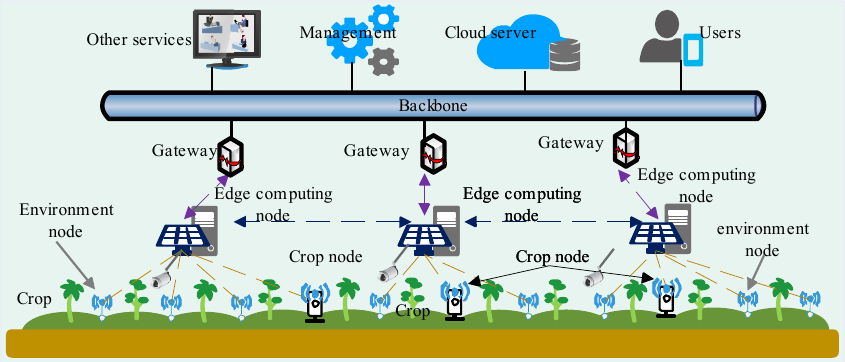
Figure 1. The data sensing framework for the entire crop lifecycle based on IoT and edge